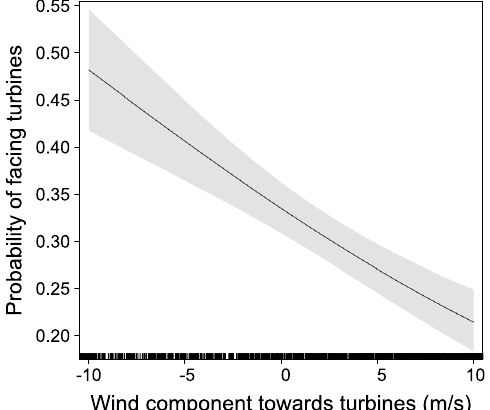
Figure 3. Generalized Linear Mixed Model (GLMM) partial effect of wind component towards turbines on probability of birds to be oriented towards turbines. Partial effect was calculated from the first model of Table 2 (that includes all predictors except turbine height) but the second model delivers identical results (compare model parameters in Table 2). The model response variable was binomial, assigned to 1 if the bird’s flight heading deviated less than 60° from the bearing to the nearest turbine or to 0 otherwise. Bird identity was included as a random effect in the model. Shaded areas represent 95% confidence intervals.